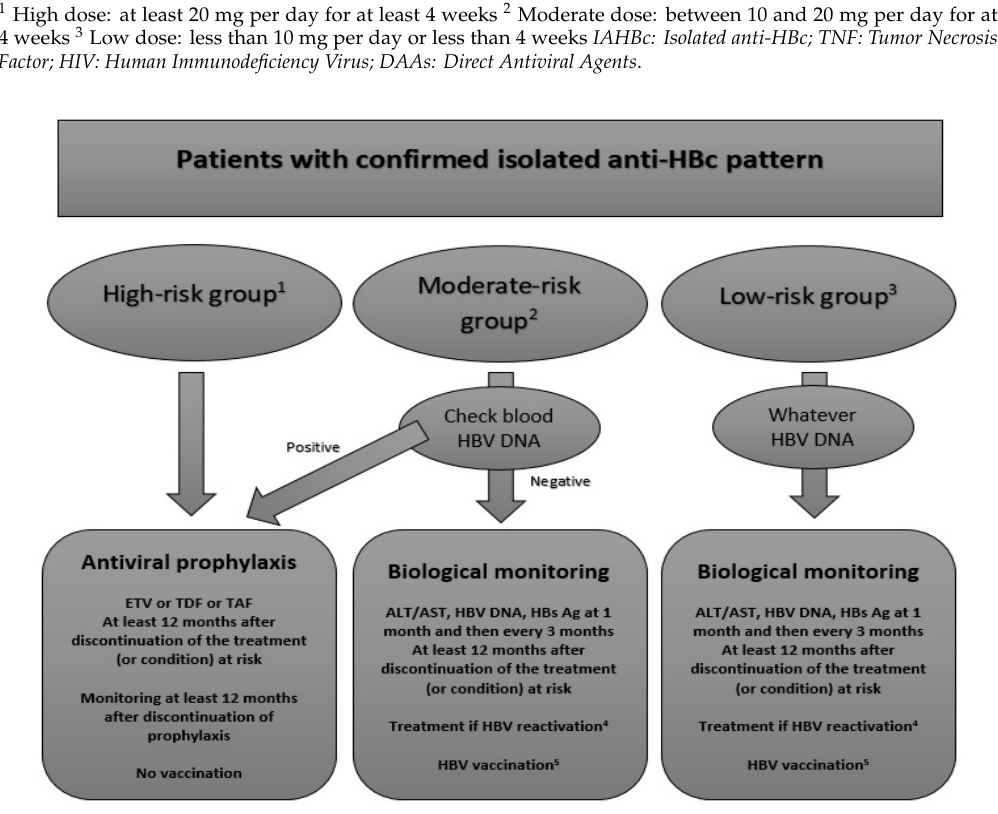
Figure 3. Proposed algorithm for the management of patients with IAHBc and immunosuppressive treatment or condition. The figure represents our proposed algorithm to manage immunocompromised patients with IAHBc according to three di ff erent risk groups. 1 High-risk group: B-cell